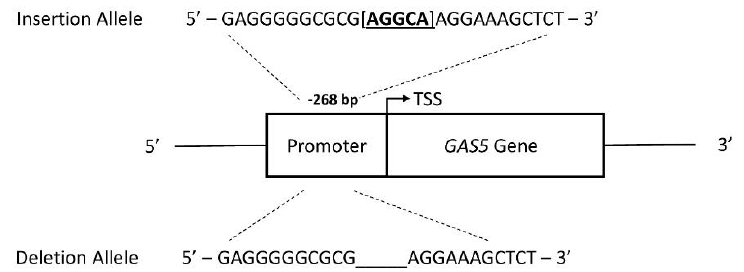
Figure 1. Schematic representation of the rs145204276 located in the promoter region of GAS5 gene.